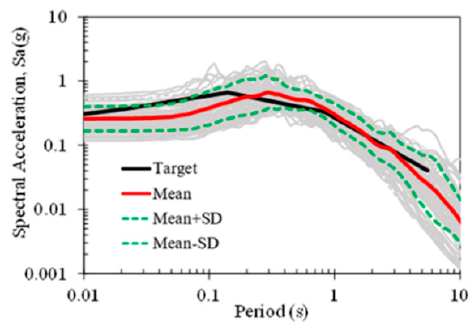
Figure 3. Response spectra of listed ground motions .